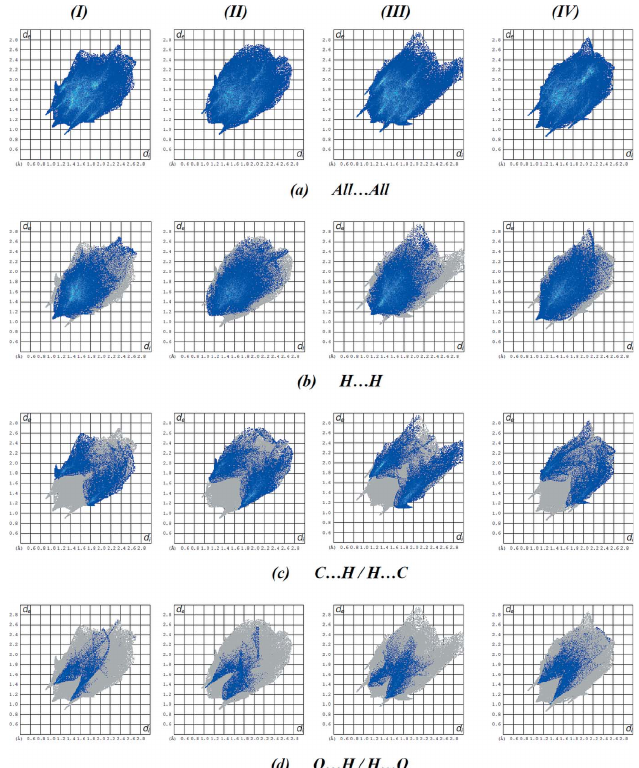
Figure 7 Aview of the two-dimensional fingerprint plots for the four molecules (I, II, III and IV) in the asymmetric unit of the title compound, showing ( a ) all interactions, and delineated into ( b ) H (cid:2)(cid:2)(cid:2) H, ( c ) C (cid:2)(cid:2)(cid:2) H/H (cid:2)(cid:2)(cid:2) C and ( d ) O (cid:2)(cid:2)(cid:2) H/H (cid:2)(cid:2)(cid:2) O interactions. The d i and d e values are the closest internal and external distances (in A˚ ) from given points on the Hirshfeld surface.